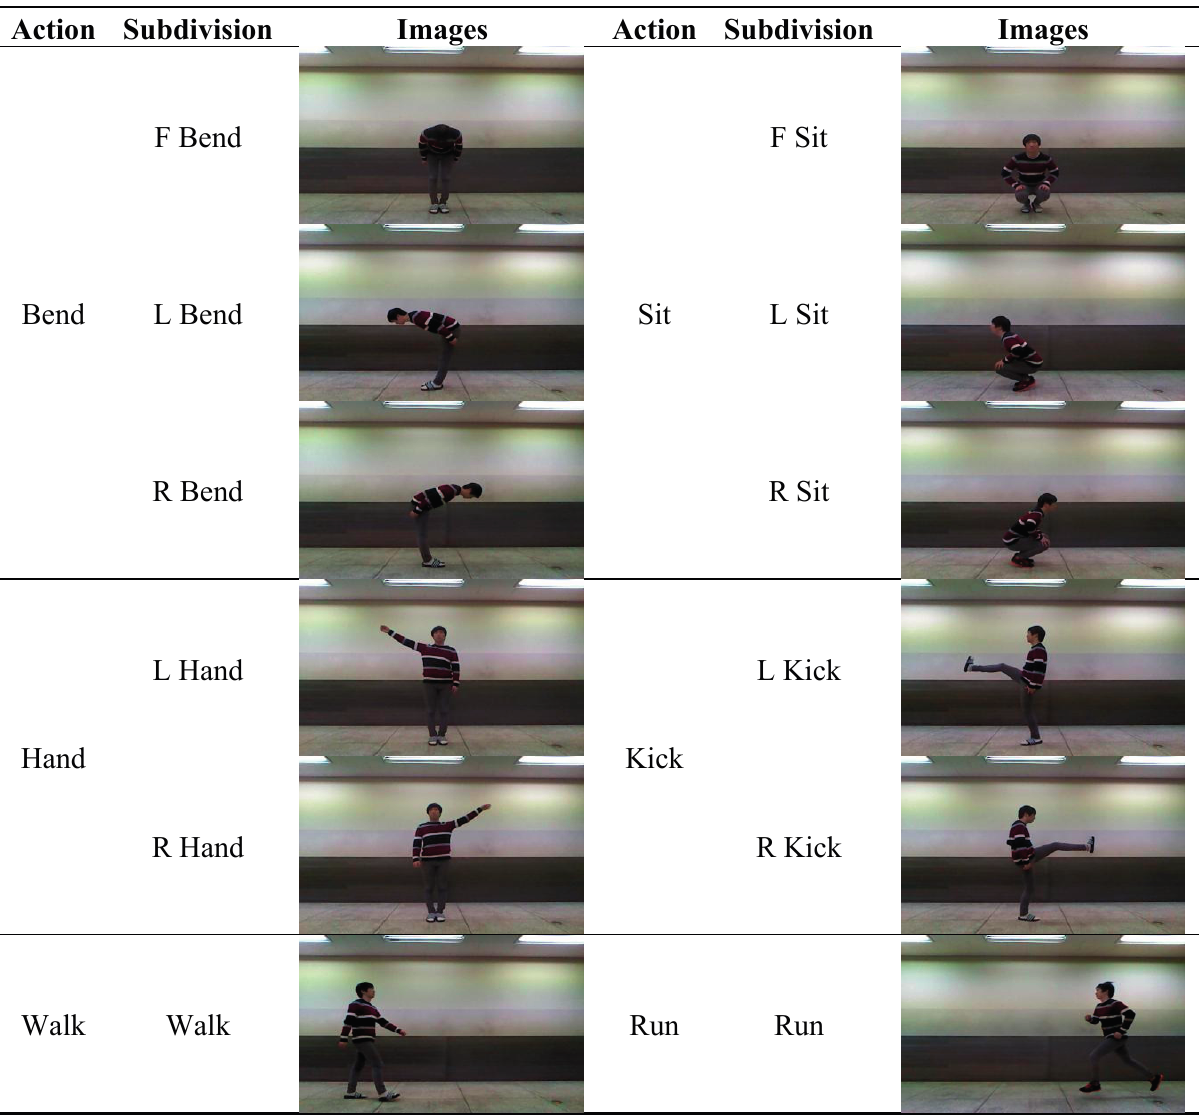
Table 1. Images and subdivision of